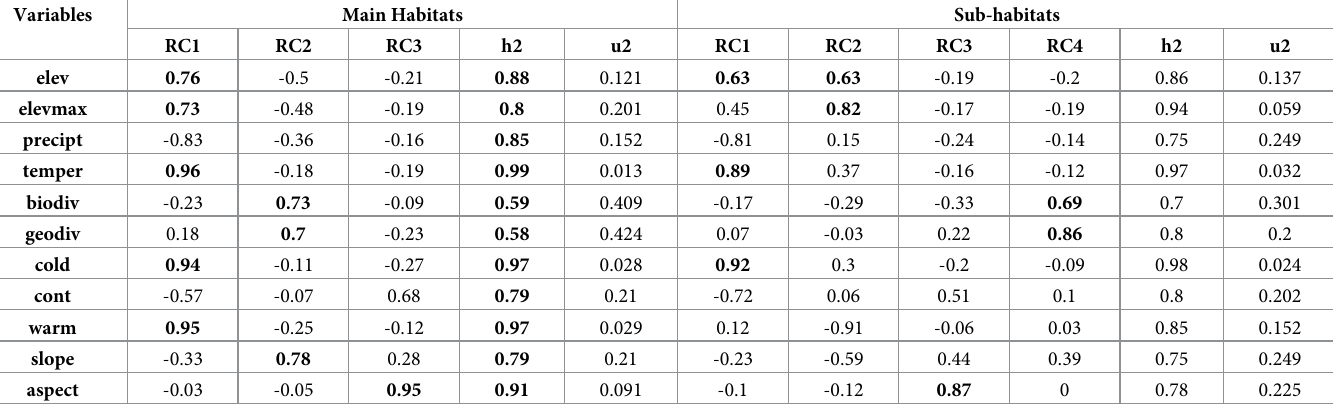
Table 5. Factor analysis